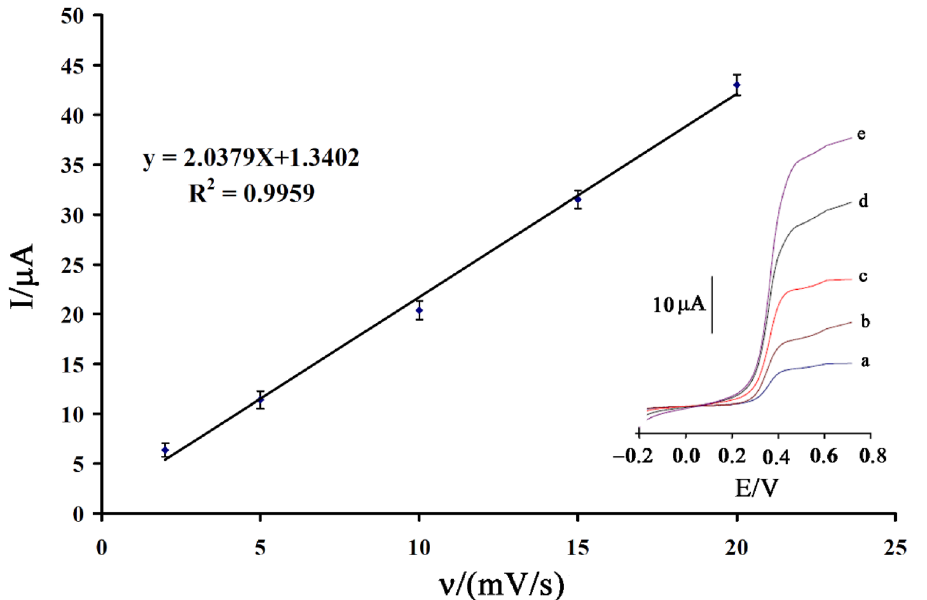
Figure 4. Plot of I pa vs. ν for the oxidation of N-acetylcysteine at the BPOFc/BMPF6/NiO-SWCNTs/CPE (n = 3). Inserts: linear sweep voltammograms of 1.0 mM N-acetylcysteine at various scan rates: ( a ) 2.0, ( b ) 5.0, ( c ) 10.0, ( d ) 15.0 and ( e ) 20 mV/s in 0.1 M PBS (pH